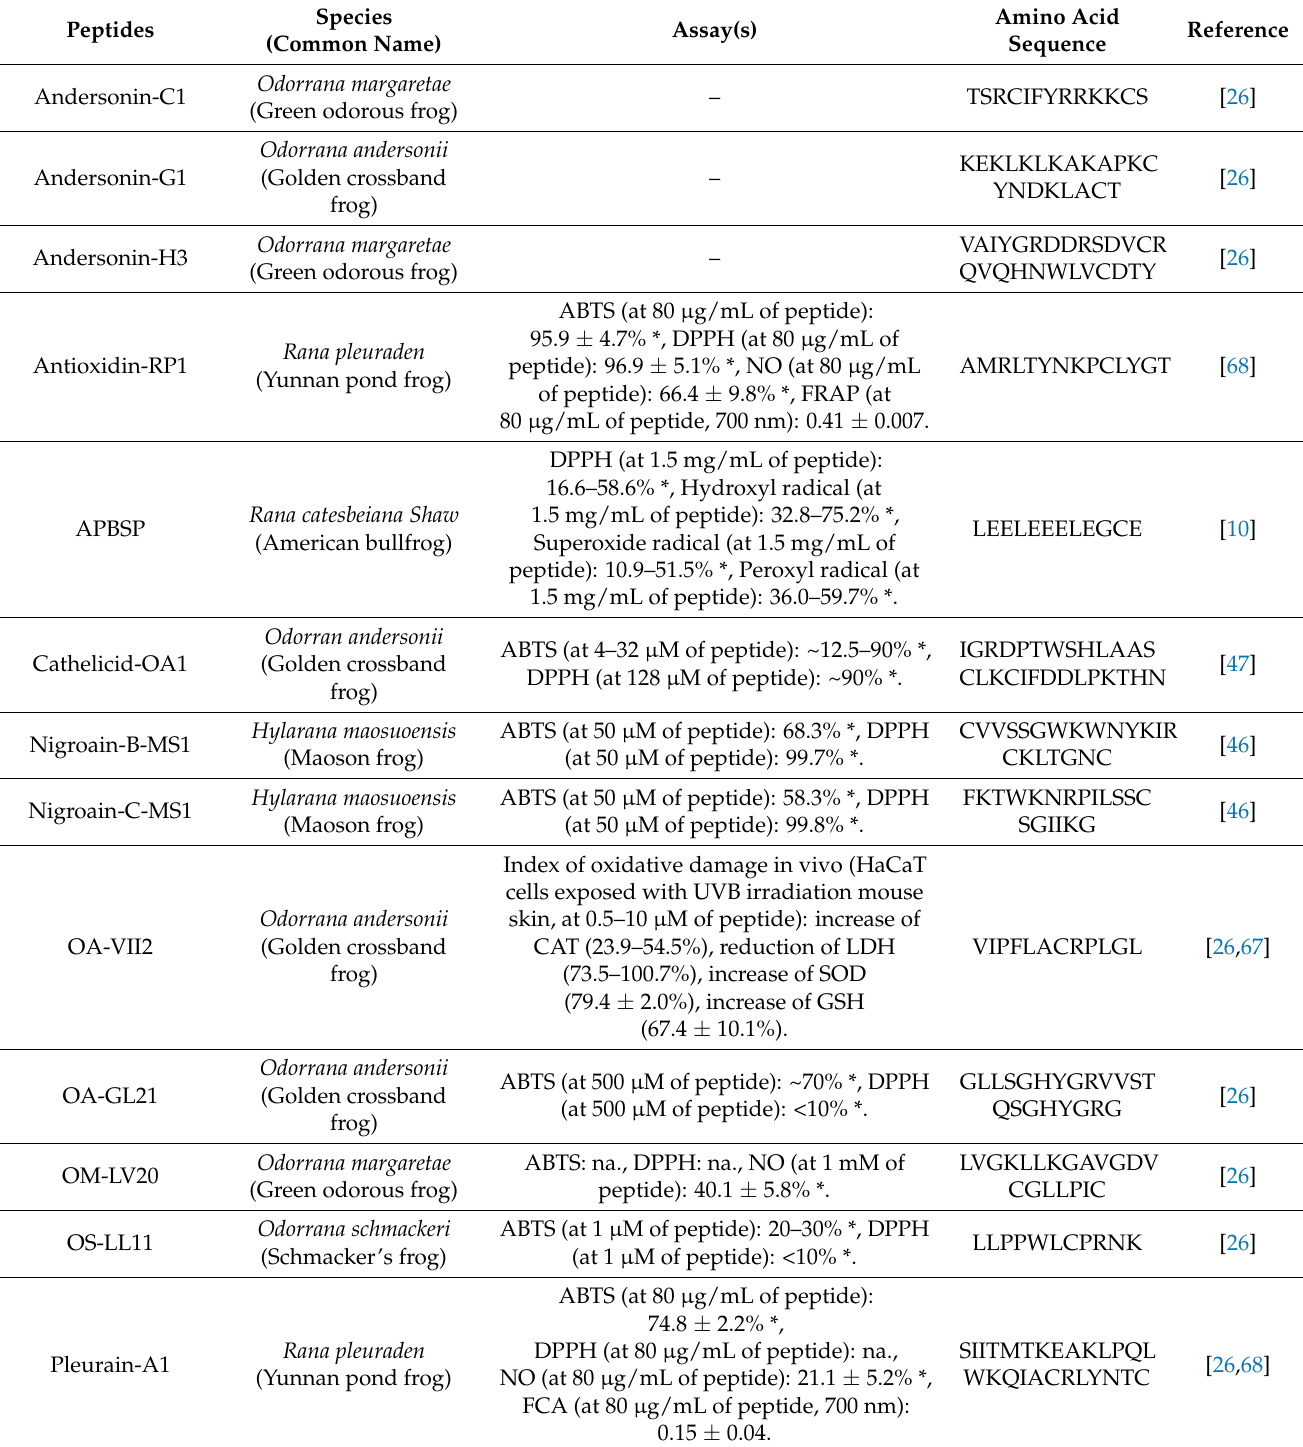
Table 2. Representative antioxidant peptides (AOPs) isolated from various species of